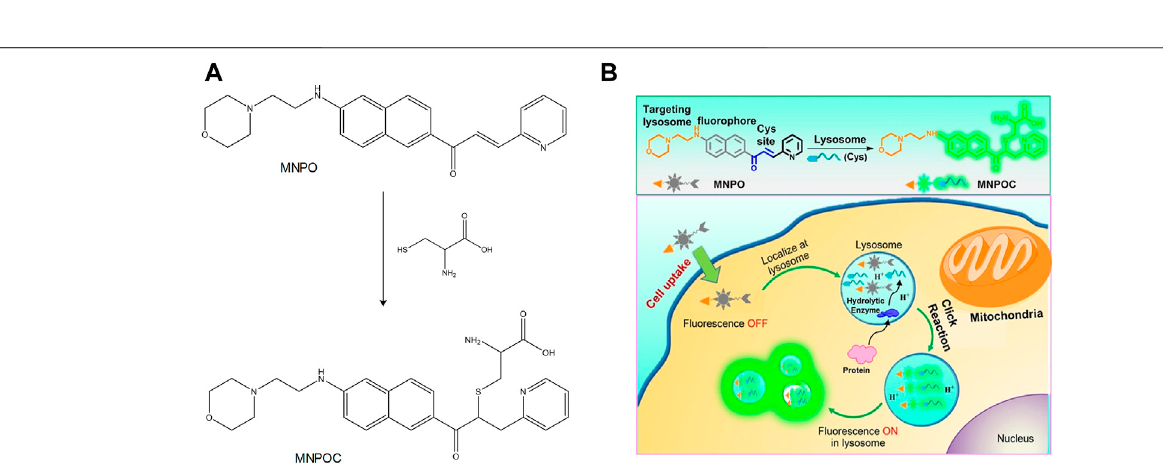
Frontiers in Pharmacology |